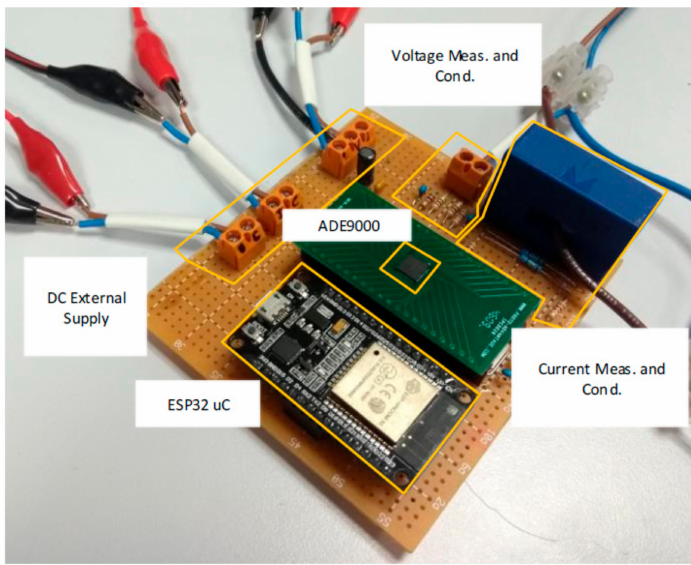
Figure 2. The IoT PQ sensor